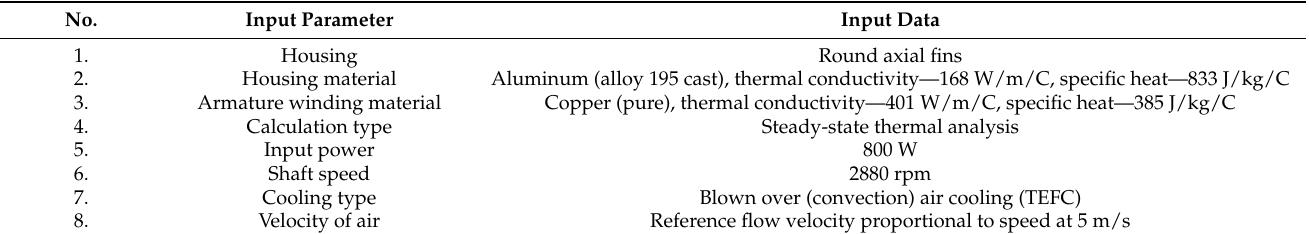
Table 5. Input parameters for thermal analysis on fan-cooled motor (ANSYS Motor-CAD).